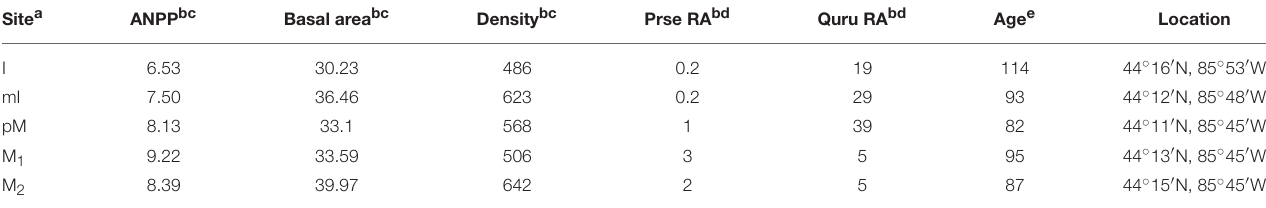
TABLE 1 | Community productivity, structure and composition attributes for forest sites where soil was collected for the plant-soil feedback greenhouse experiment. Site a ANPP bc Basal area bc